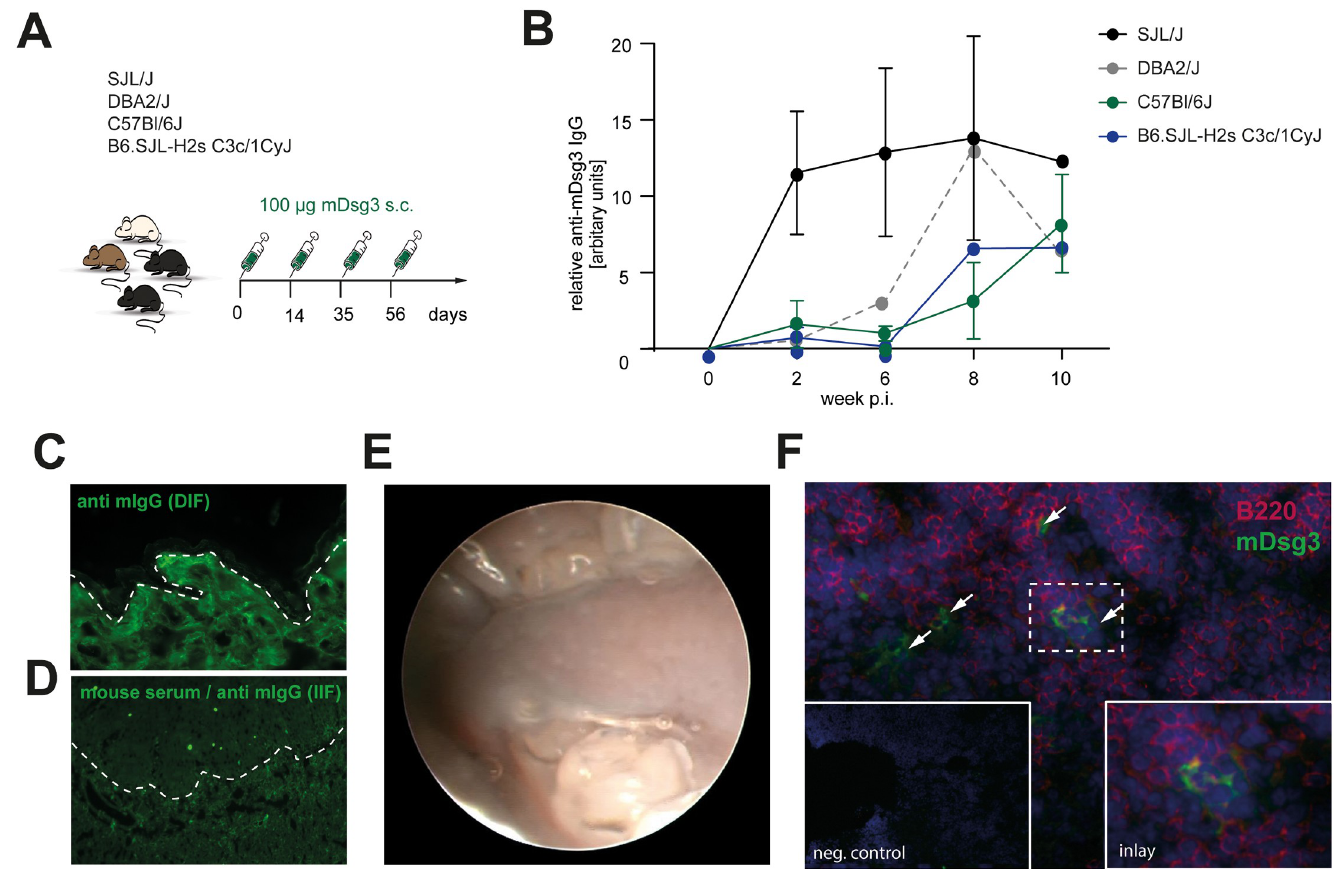
Fig 1. Immunization with murine desmoglein 3 induces antibodies against Dsg3 but no clinical PV phenotype. (A) C57Bl/6J, B6.SJL-H2s, DBA2/J or SJL/J mice were immunized 4x with mDsg3 emulsified in TiterMax ™ on days 0, 14, 35, 56. (B) Dsg3-specific IgG autoantibody titers of C57Bl/6J (n = 4), B6.SJL-H2s (n = 4), DBA2/J (n = 4) and SJL/J (n = 4) mice immunized 4x with mDsg3 emulsified in TiterMax ™ on days 0, 14, 35, and 56. (C) Direct immunofluorescent staining for anti- mouse-IgG (facial skin) at day 84. (D) Monkey esophagus was incubated with serum from immunized mice (day 84) and stained for anti-mouse-IgG. In both direct and indirect IF microscopy, no binding of IgG to the epidermis was detected. Dotted line: Dermal-epidermal junction. (E) Representative picture of endoscopy of the oral cavity showed no mucous membrane lesions at day 84. (F) The formation of mDsg3-specific B or plasma cells was confirmed by immunofluorescence of draining lymph nodes (day 84). B220: red, recombinant mDsg3 protein: green, arrows indicate Dsg3-specific B cells.